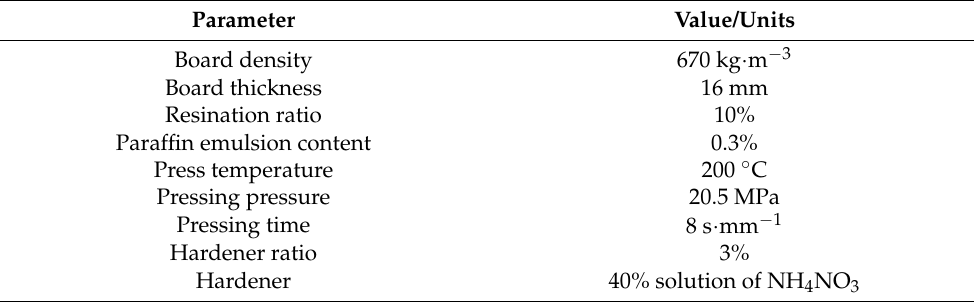
Table 2. Parameters of particleboard production.